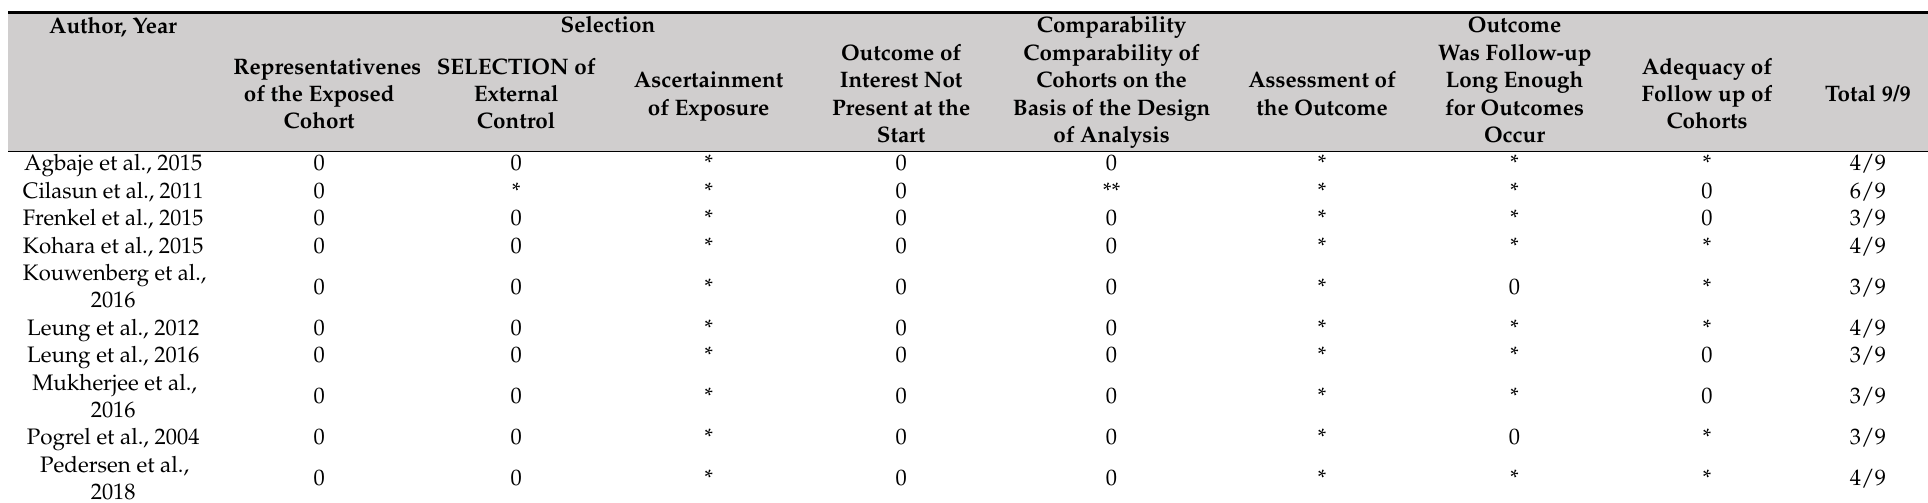
Table 3. Newcastle-Ottawa Quality Assessment Scale (NOS) Cohort and Case-control